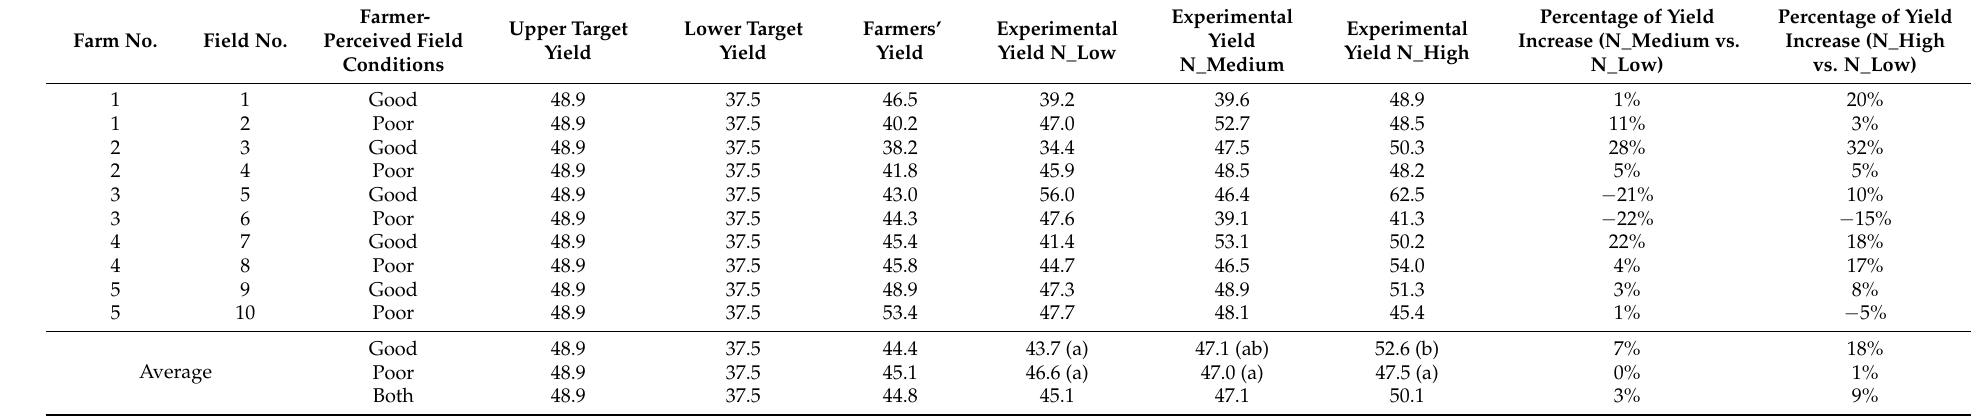
Table 3. The upper target yield (80% of the potential yield, Yp), lower target yield, and farmers’ yield of the 10 experimental fields, and the experimental yield obtained under three N fertiliser input levels in the 2018 nitrogen (N) experiment. The “farmer-perceived (good or poor) field conditions” were based on yield performance of previous years. The three N fertiliser treatments were N_low (9–117 kg ha − 1 ), N_medium (109–181 kg ha − 1 ), N_high (189–252 kg ha − 1 ). For the average experimental yield under each field condition, no shared letters between the three N treatments refers to a statistically significant difference ( p < 0.05). All yields are in ton FM ha − 1 . Farm